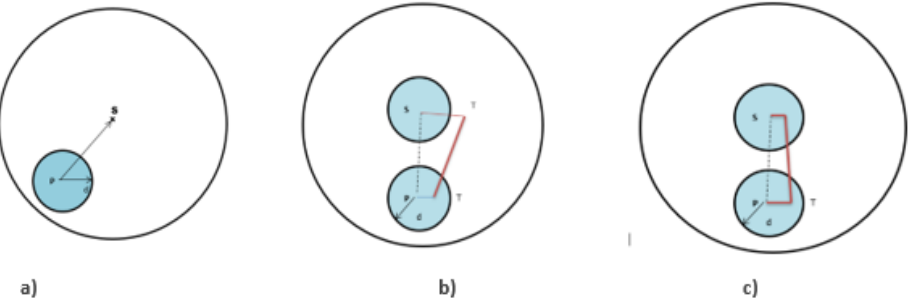
Figure 3. Choosing means of transport ( a ) Those areas for which both departure and arrival do not have easy access to public transport, ( b ) those areas where one point, departure or arrival, has easy access to public transportation and ( c ) both points of departure and arrival are located in an acceptable neighborhood by public transport (adaptation of Verbavatz and Barthelemy model) [17].